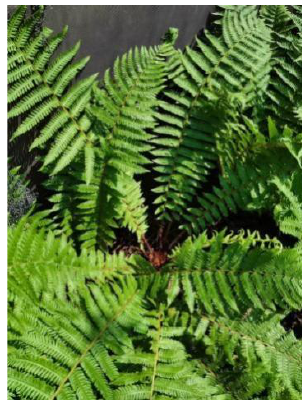
Figure 4. D. crassirhizoma